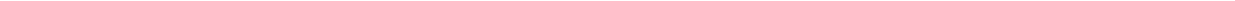
Fig. 3 The relationship between Inv9d and phenotype. a LD reveals the large inversion in Zea mays . mexicana based on 56 K SNPs in 95 mexicana accessions. LD (r 2 ≥ 0.1, red; r 2 < 0.1, pink; P < 0.1, black; P ≥ 0.1, gray) for pairs of SNPs are shown across chromosome 9. Dashed black lines delineate the likely boundaries of structural variants discussed in the text. b QTLs for ear-leaf width located in Inv9d have been detected in 6 environments. The dashed line indicates the cutoff of LOD value (LOD ≥ 2.5). c The dot-plot of gene co-linearity between B73 and mexicana on chromosome 9. The histogram indicated the gene density in a 1 Mb window. The green block covered the gene density in the Inv9d region. d The gene co-linearity between chromosome 9 of B73 and chromosome 6 of rice. e The gene co-linearity between chromosome 9 of mexicana and chromosome 6 of rice. f The phenotype of ear-leaf width of the 10 sequenced lines. The phenotype of mexicana haplotype with Inv9d (orange) and Mo17 haplotypes without Inv9d (green) are shown. The length of